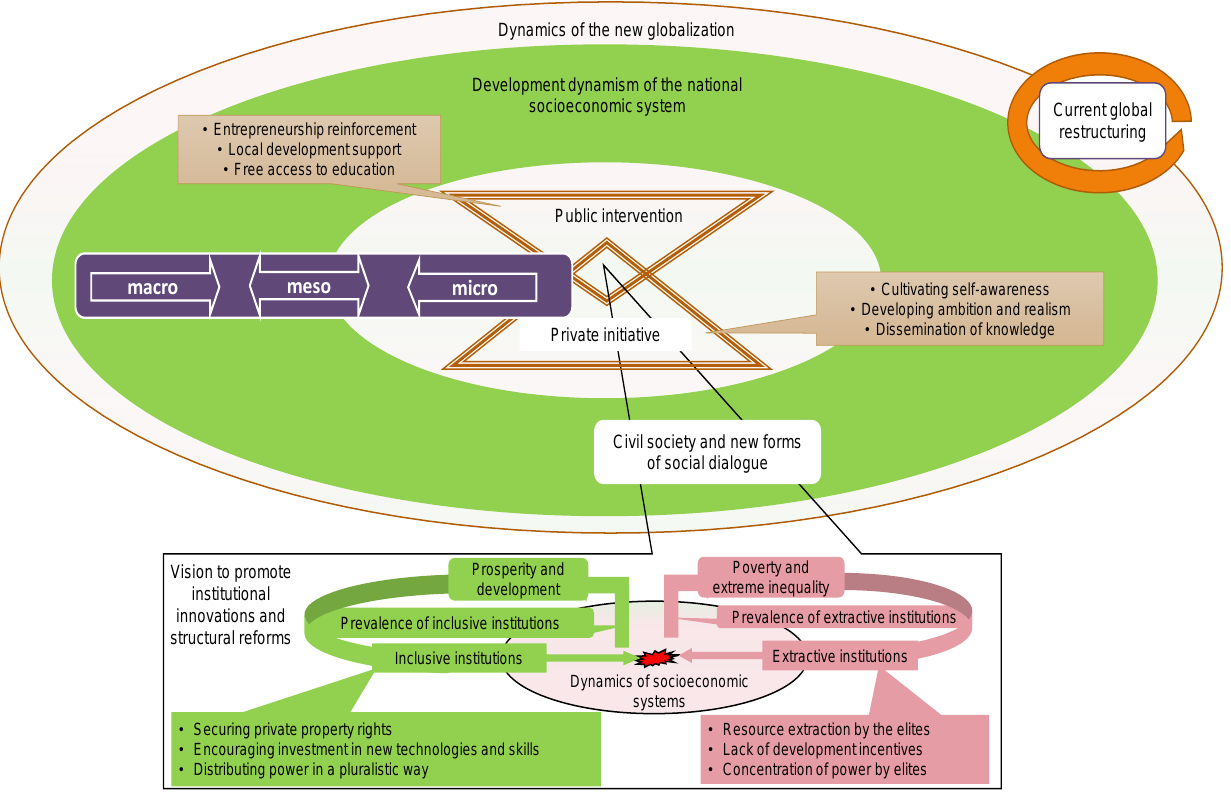
Figure 2. Shaping an institutionally adaptive socioeconomic system through new forms of social dialogue.